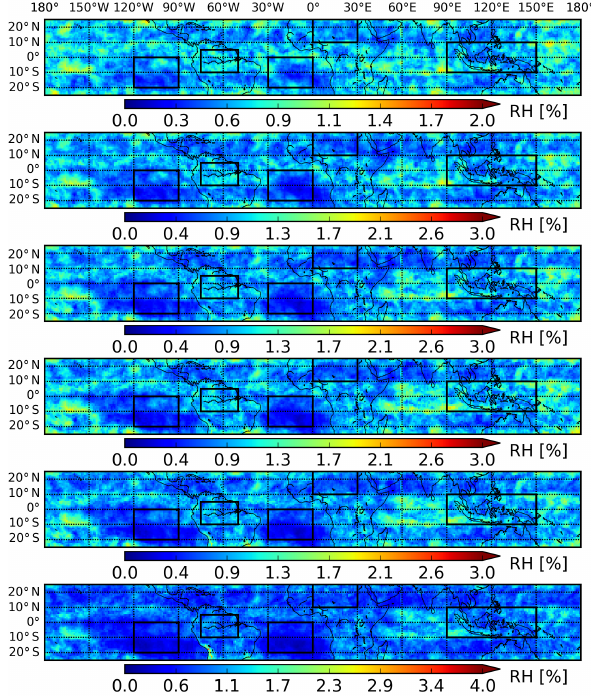
Figure 16. Mean absolute difference (with respect to ice) between measurements and the fit for Fourier series. Depicts from top to bottom are for SAPHIR channels 1–6,